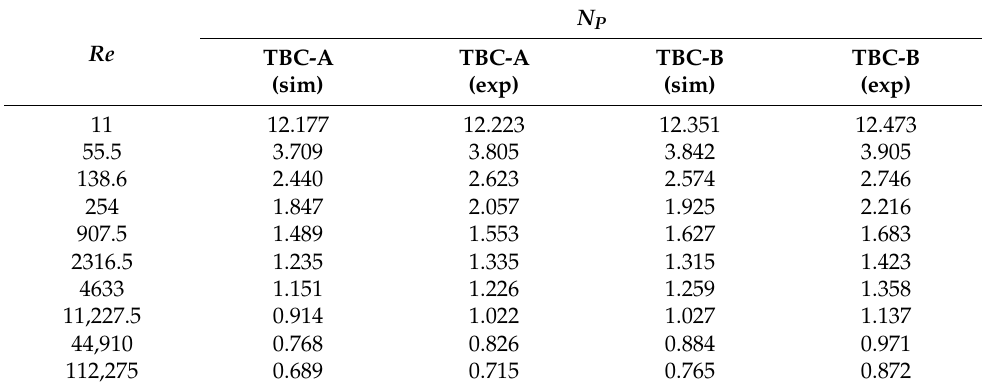
Table 3. Numerical simulation and experimental measurement values of the power